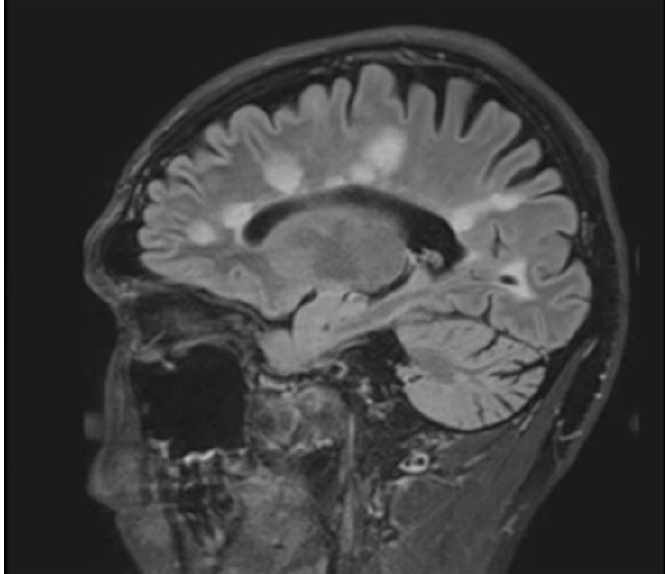
Figure 1. Sagittal fluid attenuated inversion recovery (FLAIR) image shows lesions perpendicular to lateral ventricle giving classic finger-like appearance, Dawson’s fingers.